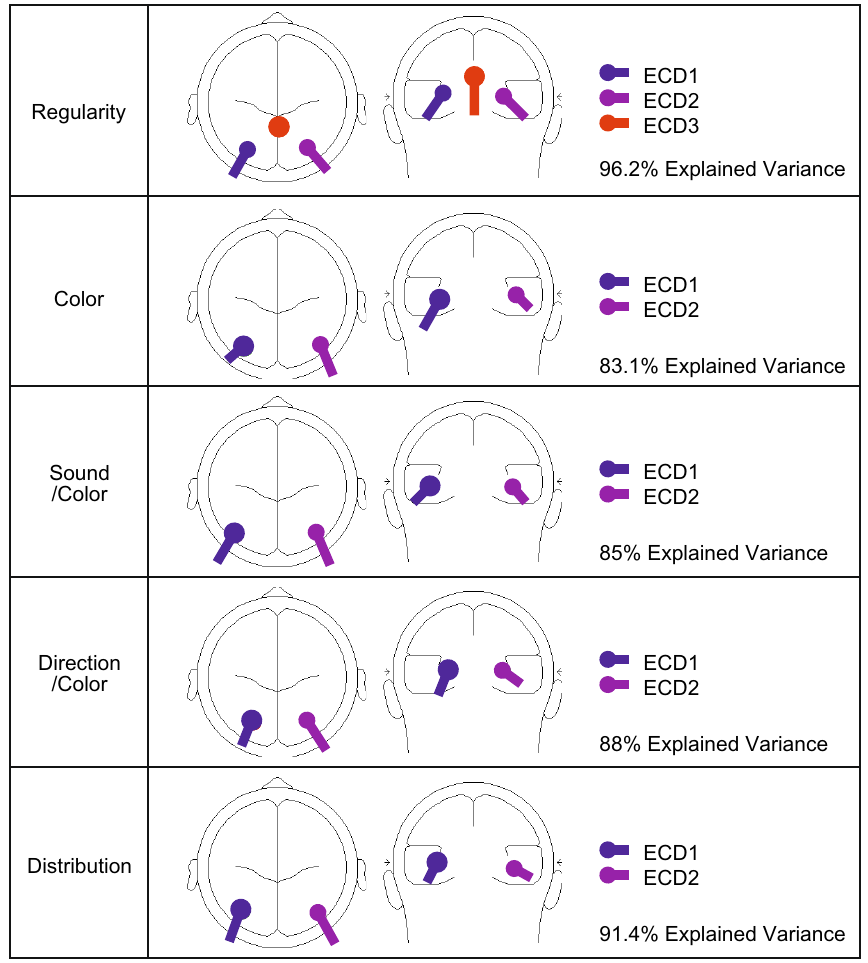
Figure 4. Glass brains for final source dipole models. Final source dipole models for each task and the corresponding amount of explained variance within the average difference waveform across all levels of PSYMM. Glass brains were created using BESA 7.0 (https